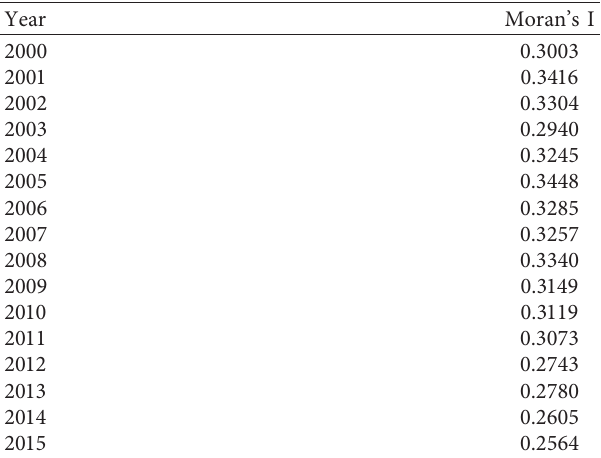
Table 2: Moran’s I test results of provincial carbon emissions from 2000 to